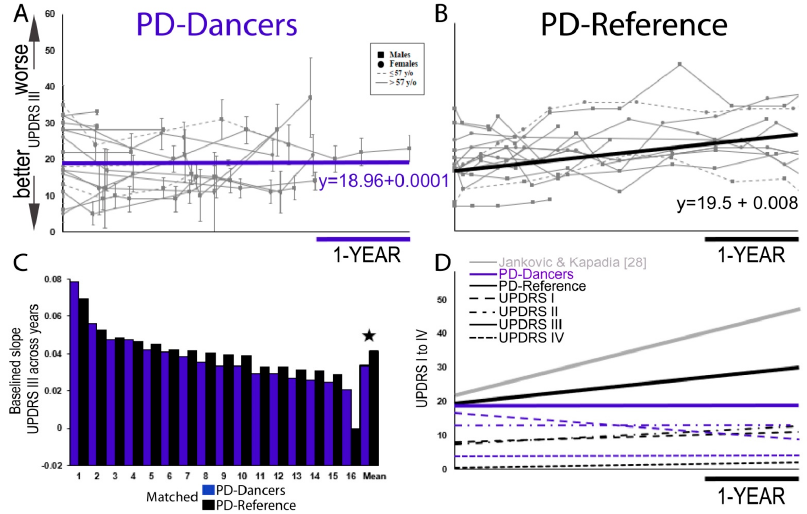
Figure 2. Progression of Parkinson’s disease: PD-Dancer average slopes are indicated by blue color lines and all PD-Reference slopes are represented by black lines. ( A ) PD-Dancer ( n = 16) scores for UPDRS part III (motor examination) across 3 years. Squares (circles) represent scores for males (females); dashed lines indicate participants ≤ 57 years of age at diagnosis, and solid lines indicate age of diagnosis at >57 years of age. Error bars represent the standard error across each experimenter (7–8) scoring for an individual testing session. Solid black line indicates average slope of 0.000146% rate of decline. ( B ) Matched PD-Reference ( n = 16) scores for UPDRS part III (motor examination). Solid black line indicates average slope of 0.008% annual motor rate of decline. Same conventions as Figure 2A, except there are no error bars from UPDRS III data since it was rated by one Movement Disorder Society (MDS) experimenter. Only 3 years of data is displayed. ( C ) Baselined individual slopes for all 16 PD-Dancers and 16 PD-References sorted from largest to smallest slopes. (cid:70) p < 0.05. ( D ) Summary of all UPDRS I–IV scores. Grey line indicates Jankovic and Kapadia (2001) [28] UPDRS III annual rate of decline.